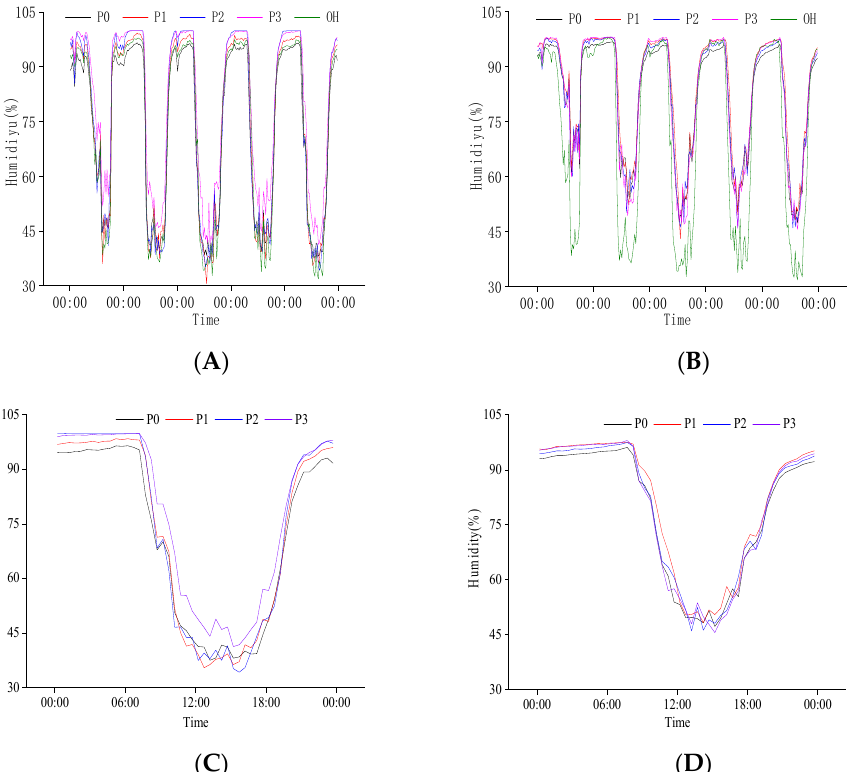
Figure 9. Daily variation in population humidity at grain filling stage. ( A ) Canopy humidity of population from 16 August to 20 August; ( B ) Baselayer humidity of population from 16 August to 20 August; ( C ) Canopy humidity of population on 20 August; ( D ) Baselayer humidity of population on 20 August. OH is the change in external humidity, P0, P1, P2, and P3 are the effects of different nitrogen fertilizers on population humidity under N1 conditions. Table 2. Effects of N and P regulation on the severity of rice sheath blight.